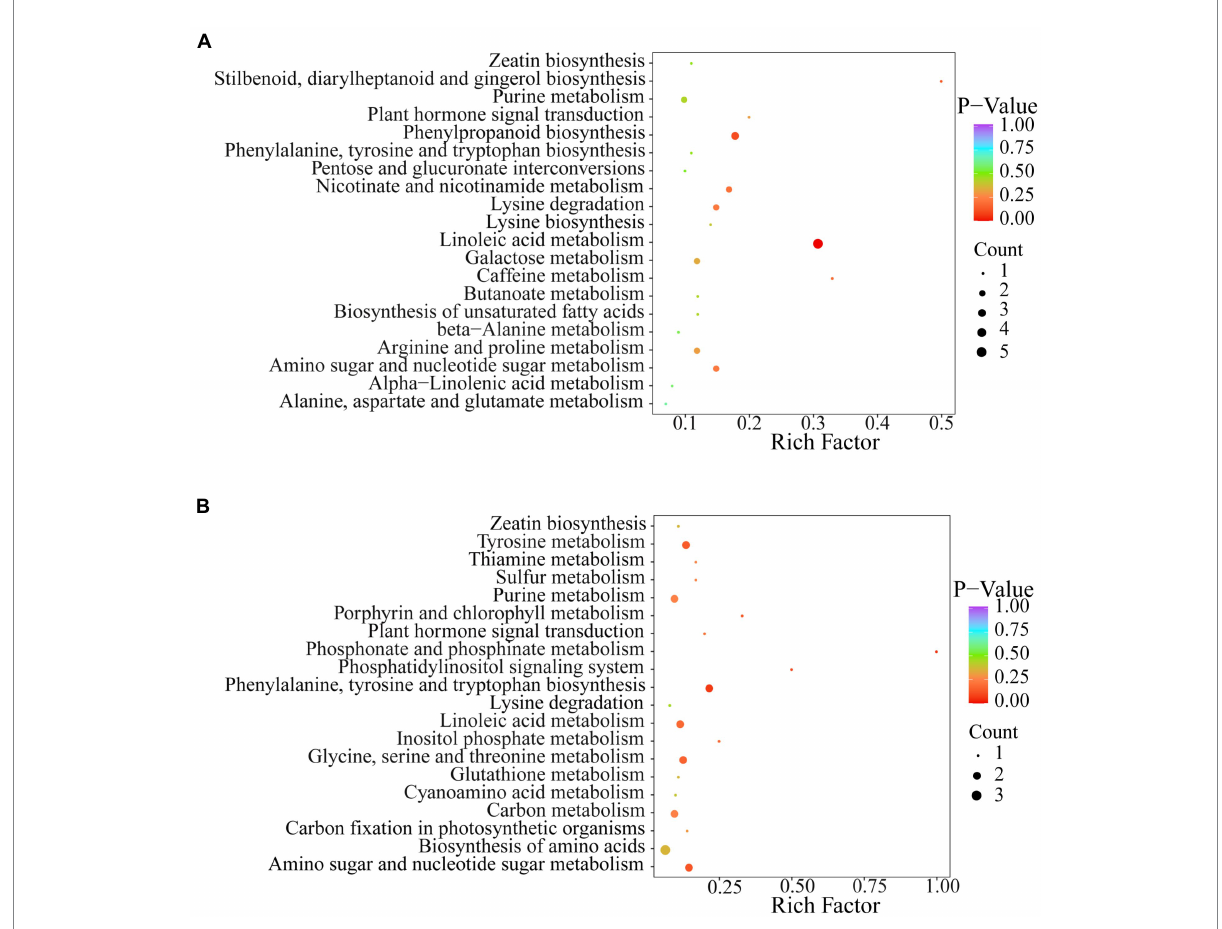
FIGURE 4 KEGG annotation and biomarker enrichment of black Se-enriched mung bean variety (A) , and green Se-enriched mung bean variety (B) . Each bubble in the figure represents a metabolic pathway and its abscissa, while the size of the bubble represents the size of the influencing factors of the pathway. Larger bubble size indicates a larger influencing factor. The color of the bubbles represents the value of the p-enrichment analysis, with darker colors indicating higher levels of